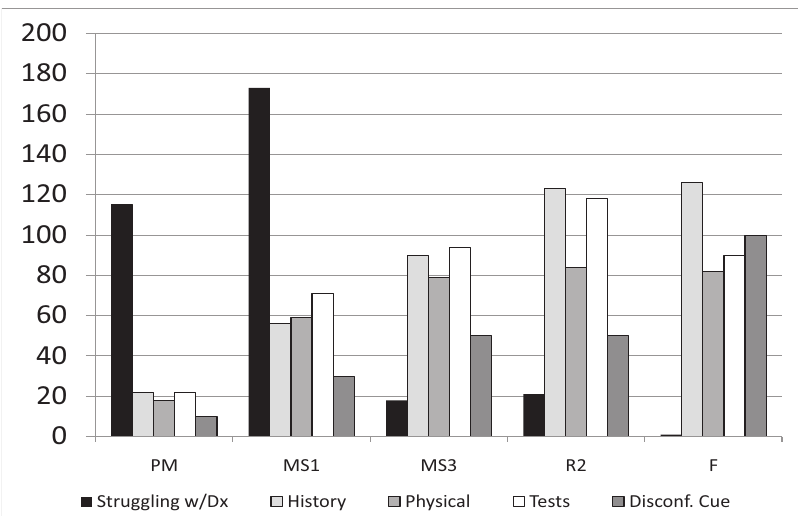
Figure 2. Average number of text units by training level for five key categories: struggling with disease definition, history, physical exam, tests, and disconfirming